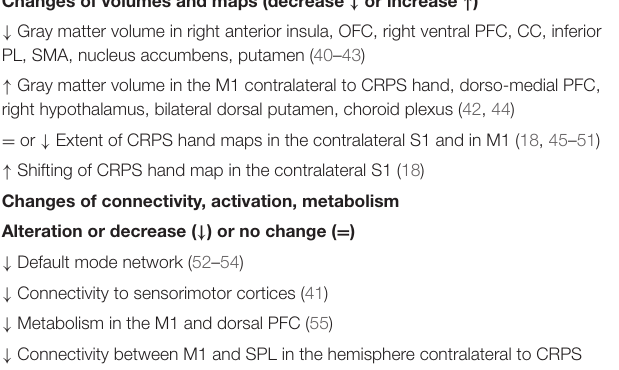
TABLE 2 | Brain changes reported in CRPS. Changes of volumes and maps (decrease ↓ or increase ↑